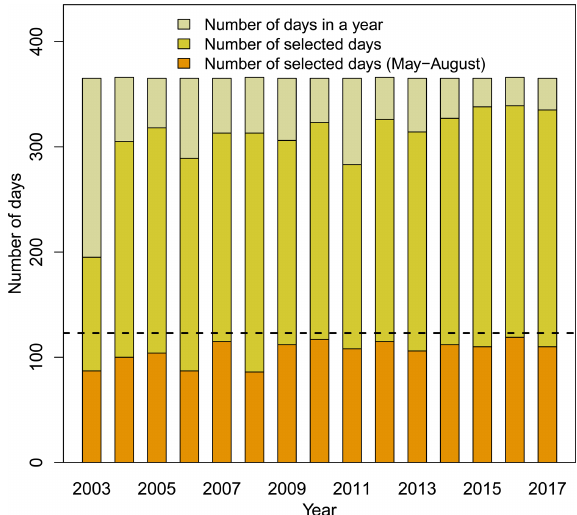
Figure 2. Number of days per year, within the period 2003–2017, with valid data selected for the analysis. The number of selected days between May and August is also depicted, the dotted line rep- resenting the number of days (i.e. 123 days) between 1 May and 31